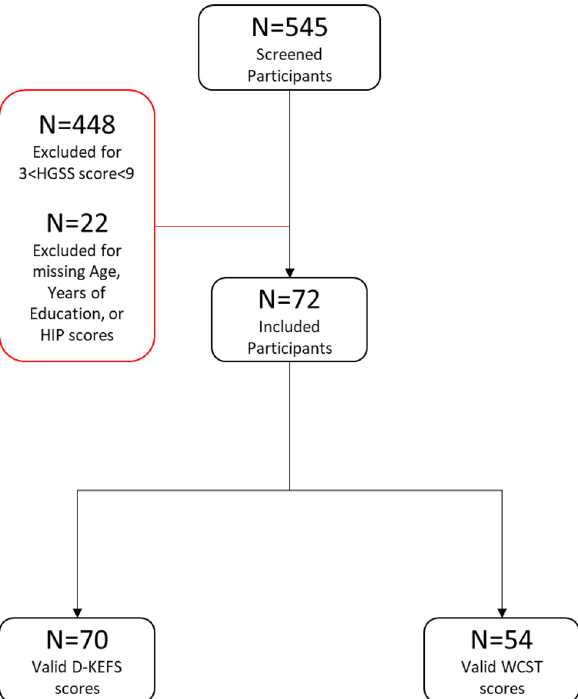
Figure 2. Consort diagram of included and excluded participants. D-KEFS = Delis-Kaplan Executive Functions System; HGSHS:A = Harvard Group Scale of Hypnotic Susceptibility; WCST = Wisconsin Card Sorting